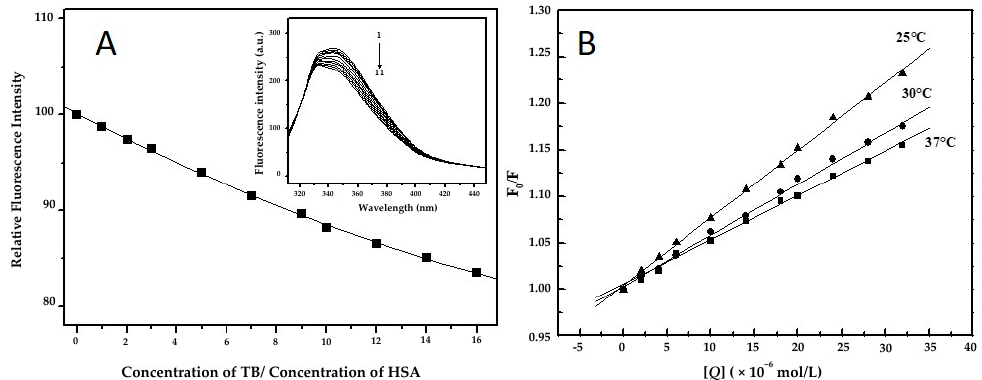
Figure 2. ( A ) Decrease of HSA fluorescence in the absence and presence of TB. Inset: Fluorescence spectra of TB / HSA complexes; c (HSA) = 2 × 10 − 6 mol / L, c (TB) = 0–32 × 10 − 6 mol / L (1–11); λ exc = 295 nm; λ em = 300–500 nm; pH = 7.4; t = 25 °C [28]. ( B ) Stern-Volmer plots for the binding of TB with HSA at different temperatures.